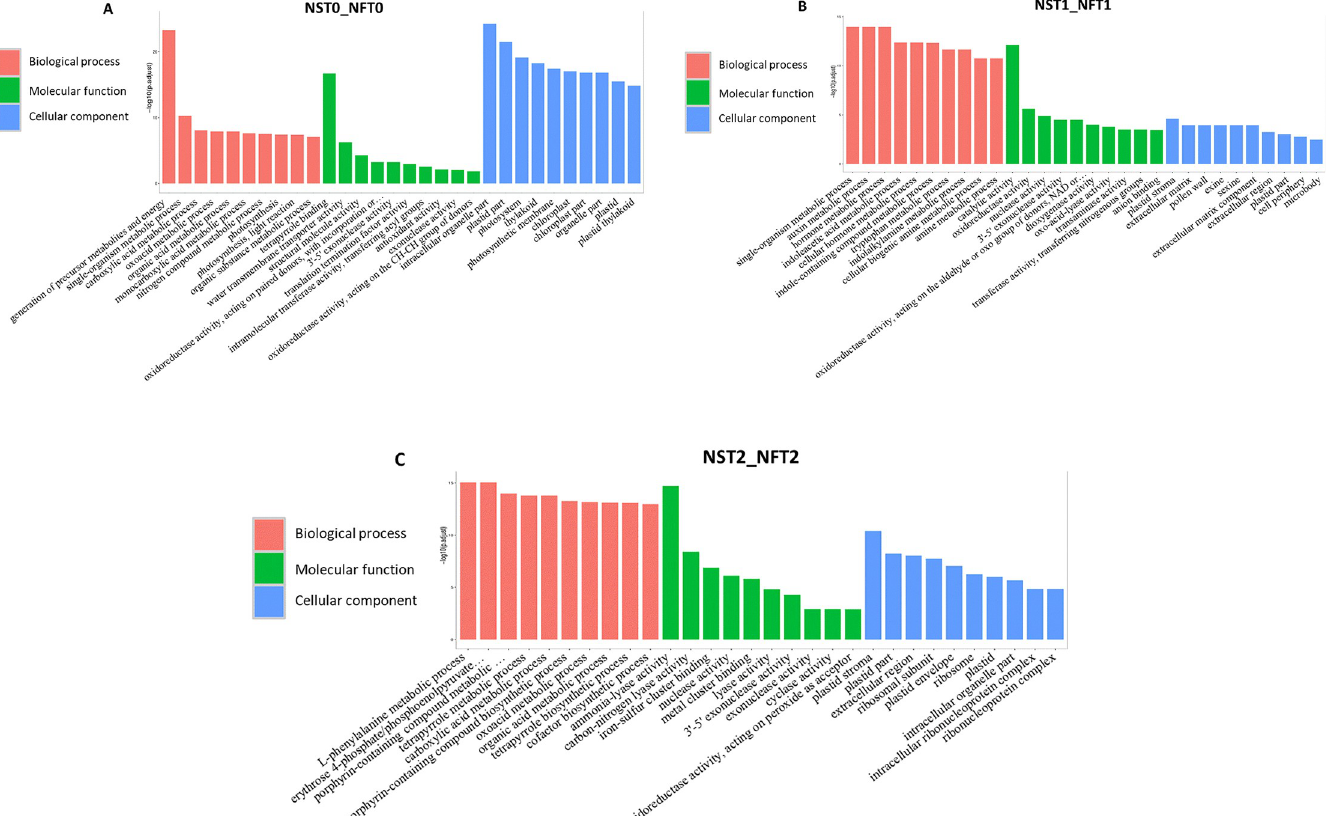
PLOS ONE | https://doi.org/10.1371/journal.pone.0243292 January 12,